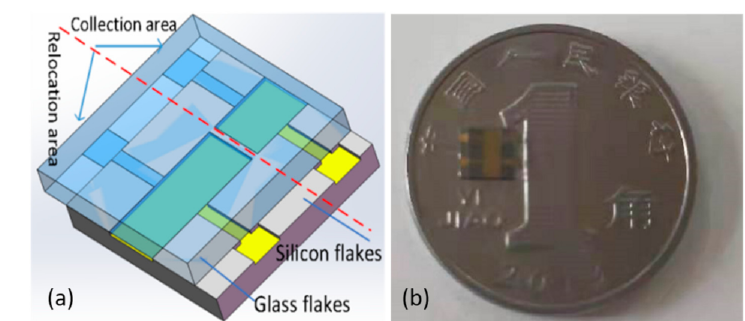
Figure 10. ( a ) the three-dimensional structure of the sensor ( b ) the physical view of the sensor.